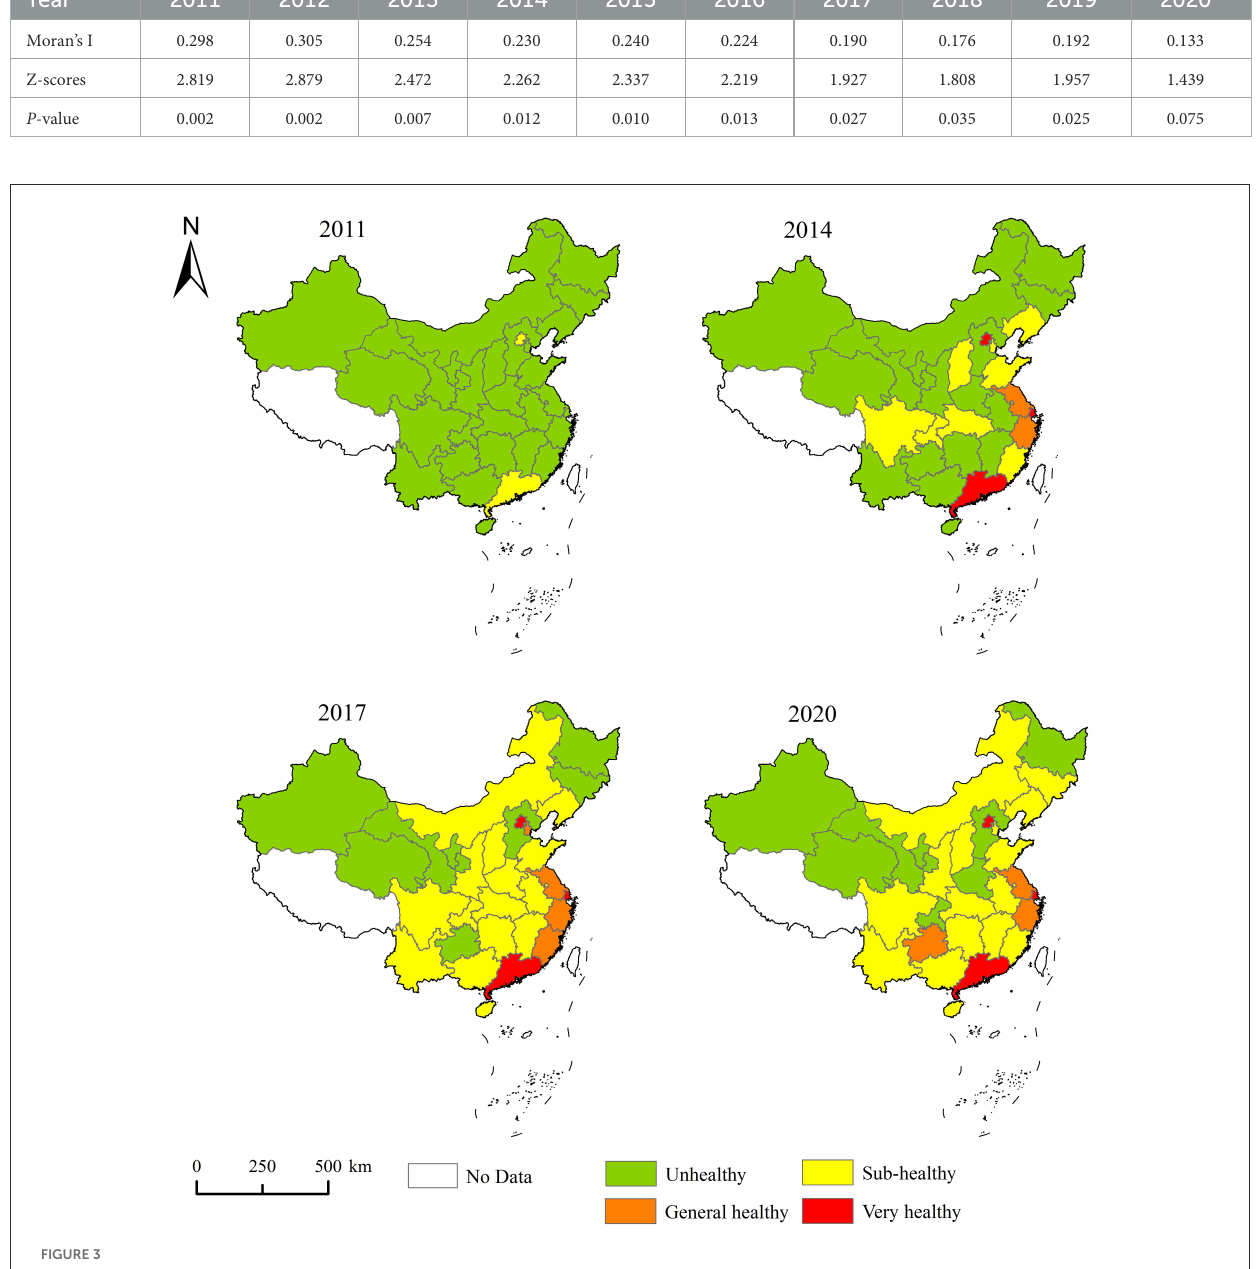
FIGURE3 Spatial distribution patterns of tourism ecosystem health.